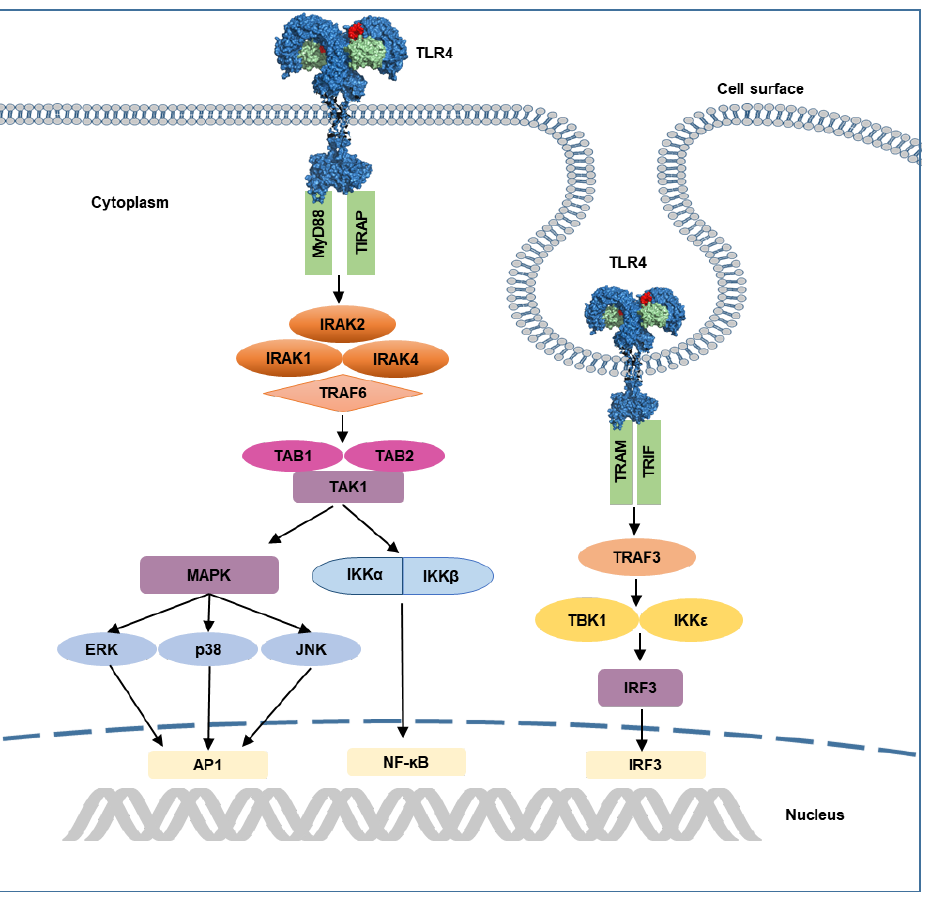
Figure 4. Illustration of TLR4 signaling pathway. Recognition of LPS activates MyD88-dependent and TRIF-dependent pathways. In MyD88-dependent pathway, recruitment of MyD88 by TIRAP initiates the interaction of IRAKs and TRAF6, that leads to the activation of transcription factors. Endocytosis of TLR4 initiates TRIF-dependent signaling, which involves recruitment of TRIF and TRAM, that leads to subsequent induction of TBK1 and IKK ε , as well as activation of transcription factor IRF3. AP1, activated protein 1; ERK, extracellular-regulated kinase, IRAK, interleukin receptor-associated kinase; IKK, inhibitor of ĸ B kinase; IRF3, interferon response factor 3; JNK, c-Jun N-terminal kinase; MAPK, mitogen-activated protein kinase; MyD88, myeloid differentiation primary response protein 88; NF- ĸB , nuclear factor ĸB; p38, protein 38; TAK1, transforming growth factor β -activated kinase 1; TBK1, TANK-binding kinase 1; TIRAM, TRIF-related adaptor molecule; TIRAP, TIR domain-containing adaptor protein; TRAF, tumor necrosis factor receptor-associated factor.